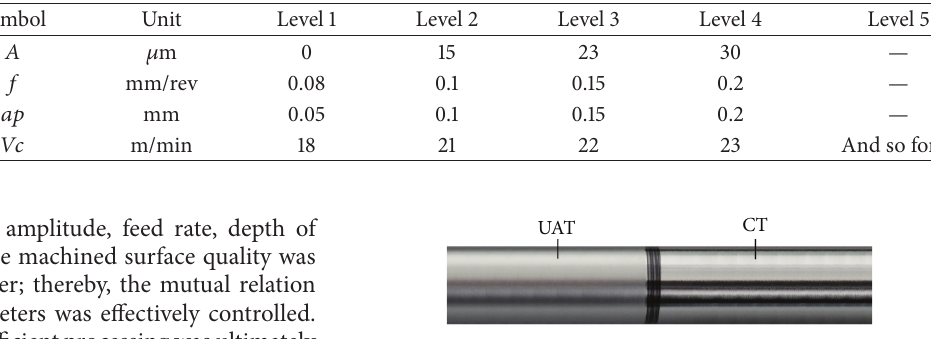
Table 4: Process parameters and their levels used in the experiment.